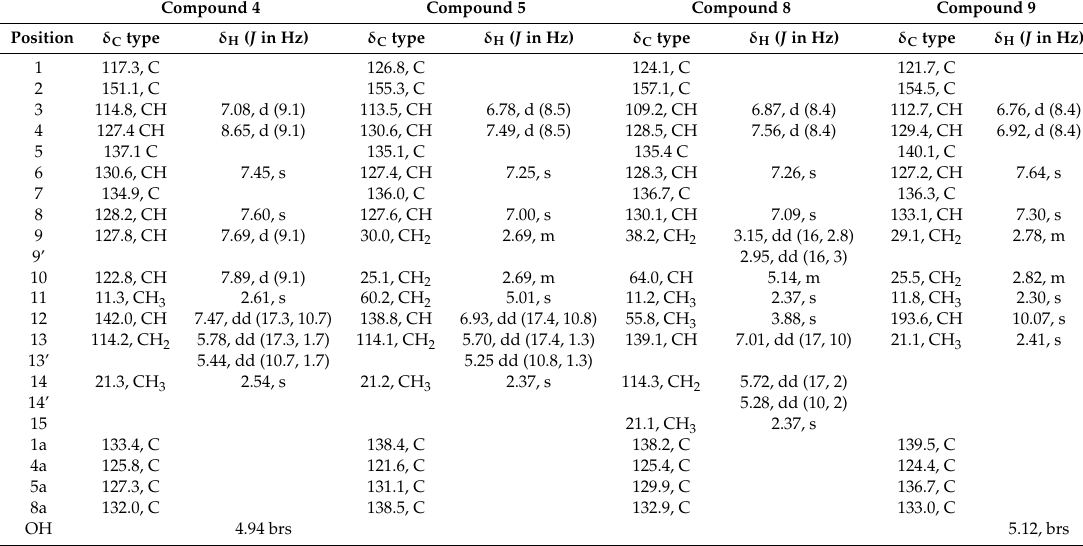
Table 2. 1 H and 13 C data for compounds 4 , 5 , 8 and 9 (in CDCl 3